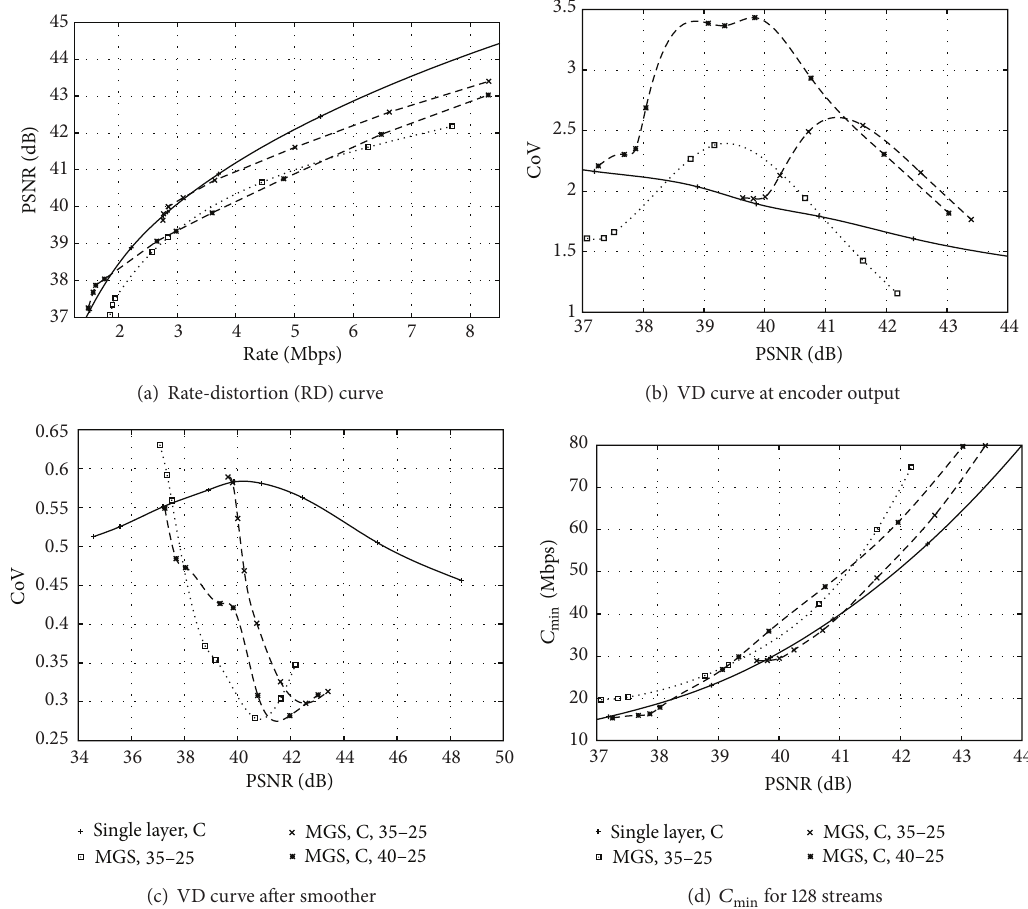
Figure 5: Illustration of traffic characteristics and link bandwidth requirements for Sony encoded with H.264 SVC with medium-grain scalability (MGS) for base layer QPs B = 35 and 40 and enhancement layer QP 𝐸 = 25 with and without QP cascading (C), in comparison with H.264/AVC single-layer encoding with cascading